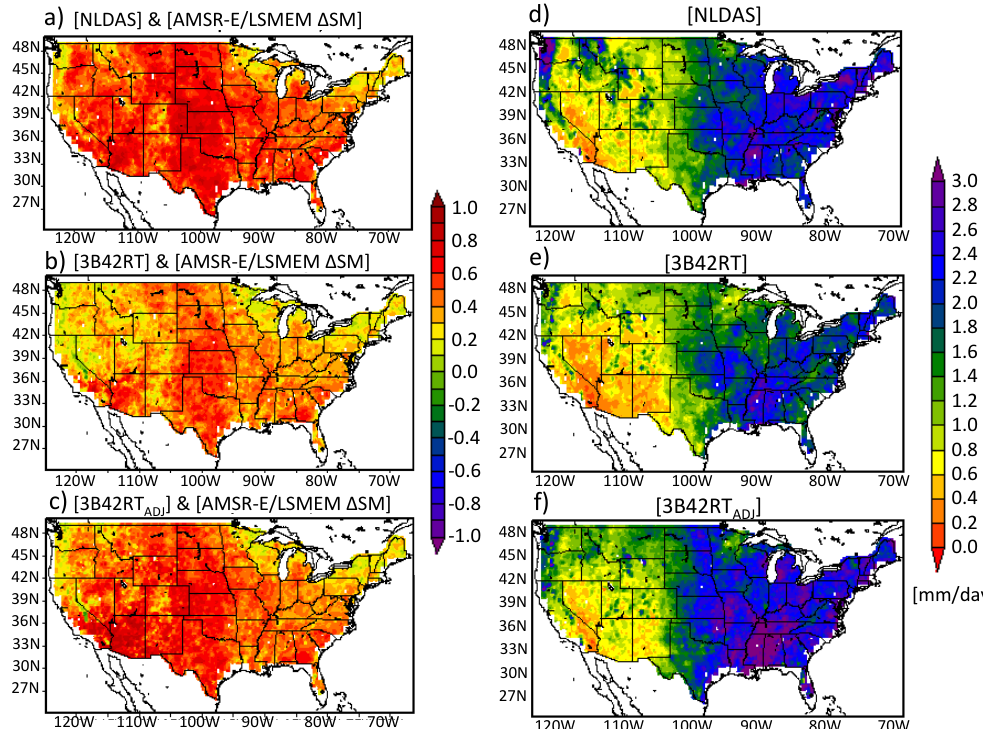
Figure 9. Pearson correlation coefficient between AMSR-E/LSMEM (cid:49) SM and precipitation (from 1 January 2003 to 31 July 2007): (a) NL- DAS, (b) 3B42RT and (c) 3B42RT ADJ ; annual mean precipitation in (d) NLDAS, (e) 3B42RT and (f) 3B42RT ADJ of time steps with AMSR-E/LSMEM (cid:49) SM